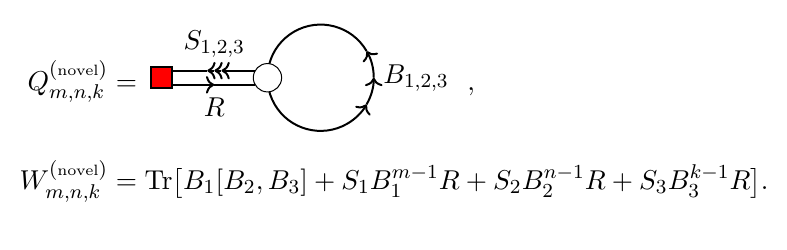
with k = 1 , 2 , . . . , m , the pausers y k m